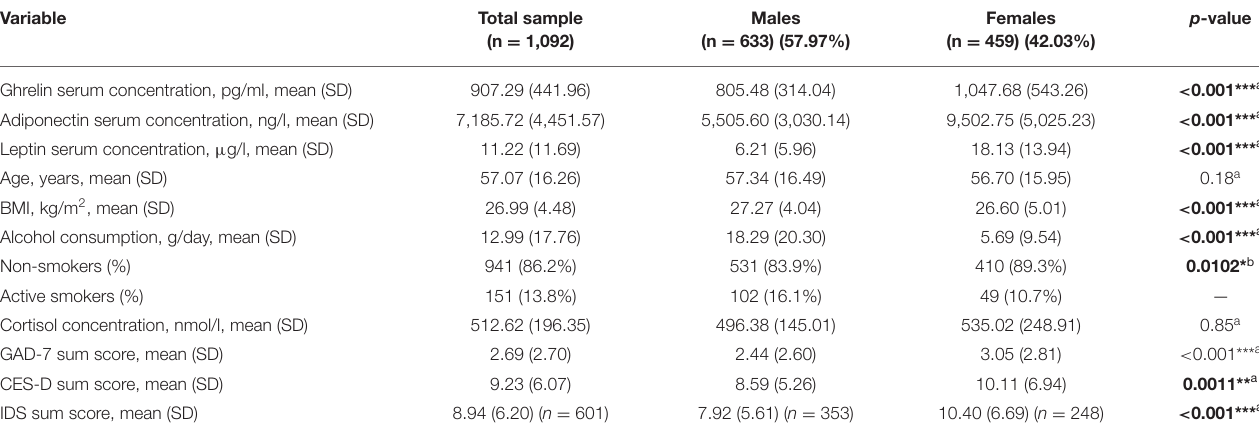
TABLE 1 | Description of the sample.